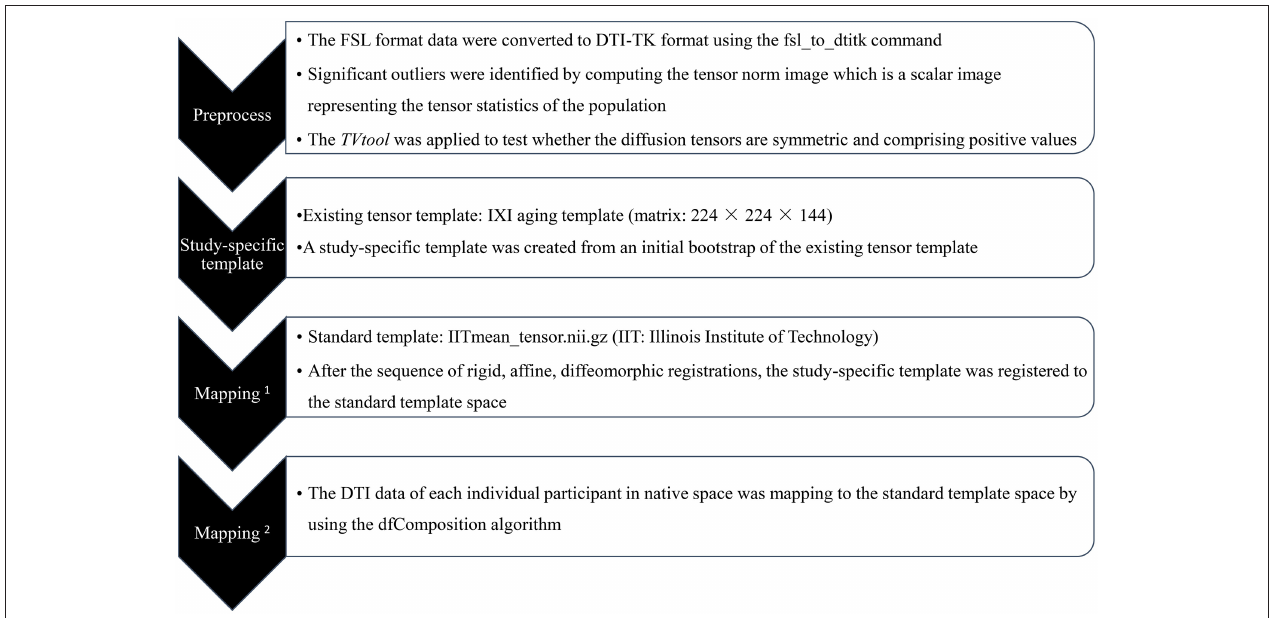
FIGURE 1 | Flow diagram of tract-based spatial statistics (TBSS) registration process followed by DTI-TK